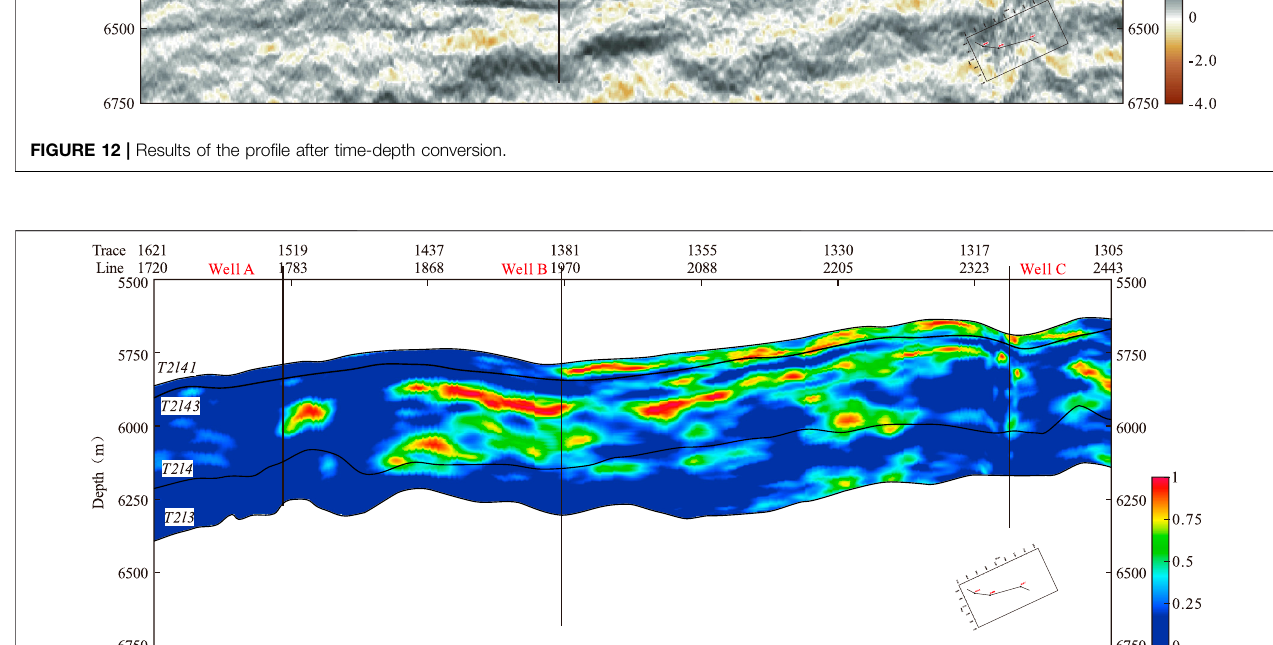
Frontiers in Earth Science |